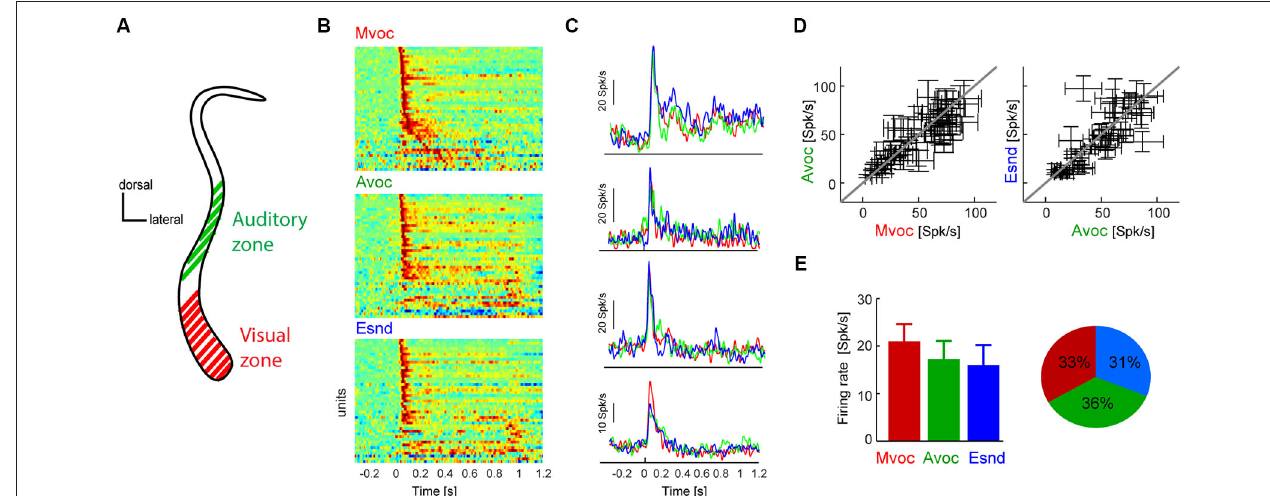
1 s. (C) Example data from four units, showing the average response time course within each category. Except for the bottom example, responses were highly similar between sound categories. (D) Response amplitudes for all units and sound categories. Responses were calculated in 100 ms windows centered on the peak response for each individual sound. Errorbars indicate each units’ average responses to each category and the standard error across sounds within each category. (E) Population averaged response amplitudes (mean and s.e.m.) and the fraction of units “preferring” each category (defined based on the maximal response amplitude). Sound categories: Mvoc: conspecific vocalizations; Avoc: sounds of other animals; Esnd: environmental